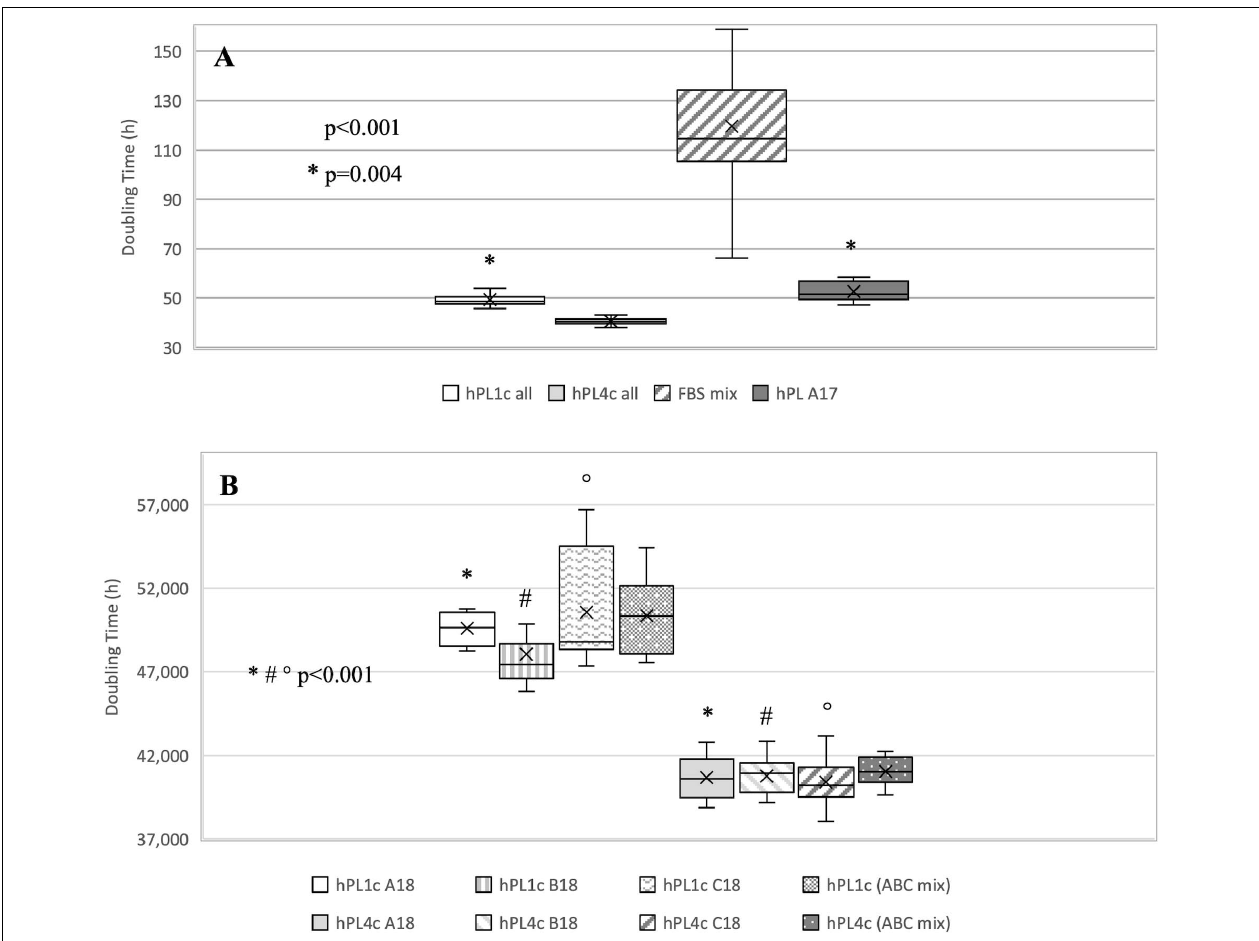
FIGURE 4 | Boxplot of hMSC expansion at 7 days of culture in the presence of FBS vs. hPL1c and hPL4c. At the start of the expansion assay (day 0), 4,000/cm 2 hMSC are seeded in the presence of 10% FBS mix and 5% of three different batches of hPL1c and hPL4c. Cell proliferation is expressed as doubling time (hours). X indicates sample mean. (A) The results of all experiments regardless of hMSC and hPL batches used. hPL A17: control-hPL batch previously produced and characterized (18 donations of BC, one freeze/thaw cycle, plasma without removal of fibrinogen, sodium heparin 2 IU/ml). hPL4c (mean DT 40.61 ± 1.11 h) shows an expansion effect on hMSC higher than the hPL1c (mean DT 49.41 ± 2.62 h, p < 0.001), hPL A17 (mean DT 52.66 ± 3.90 h, p < 0.001), and the FBS mix (mean DT 119.70 ± 32.36 h, p < 0.001). The proliferative effect of hPL1c is comparable to that of hPL A17 ( p = 0.004), but it is higher than that of the FBS mix ( p < 0.001). Medians: hPL1c all 48.60, hPL4c all 40.56, FBS mix 114.70, hPL A17 51.58. (B) The results for each hPL1c and hPL4c batch and for the mix (batches A + B + C) at one and four cycles. hPL4c demonstrates a greater proliferative effect than hPL1c even considering single batches ( p < 0.001). No significant differences in DT